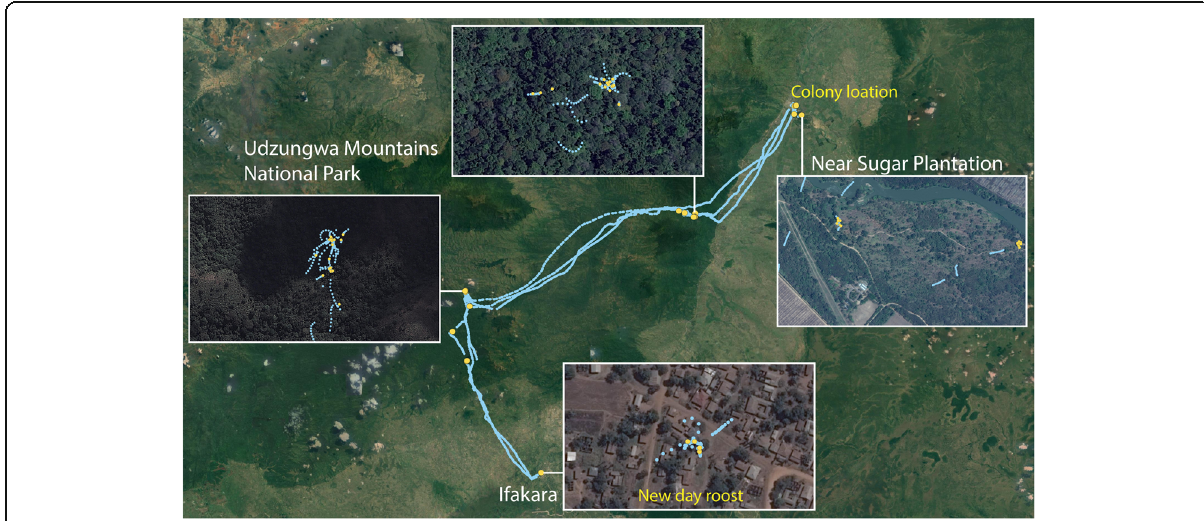
Fig. 4 The flight path of bat K5310, who frequented both protected and urban areas, flying a cumulative distance of up to 97.57 km during a single foraging night (yellow circles depict foraging areas/feeding roost